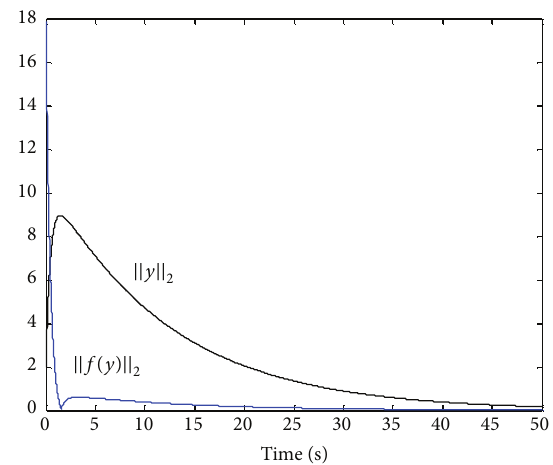
Figure 2: Relation between the 2-norms of the state, 𝑦 , and the function, 𝑓(𝑦) .